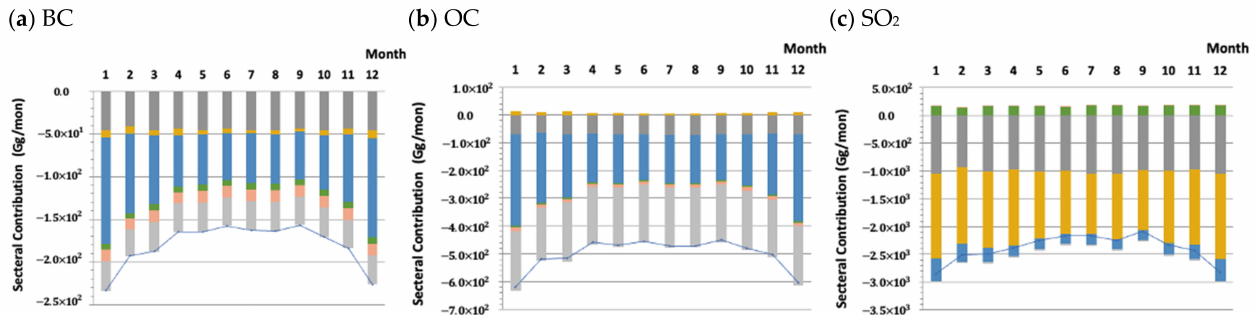
Figure 2. The monthly global means of the differences in total and sectoral emissions (Gg/mon), such as agriculture (agr, in red), energy (ene, in gray), industry (ind, in yellow), residen- tial_commercial_others (RCO, in blue), international shipping (shp, in green), solvent-production applications (slv, in light blue), road transportation (road, in peach), and waste (wst, in light grey) in CEDS 2014 from CEDS 2019 of ( a ) BC, ( b ) OC, and ( c ) SO 2